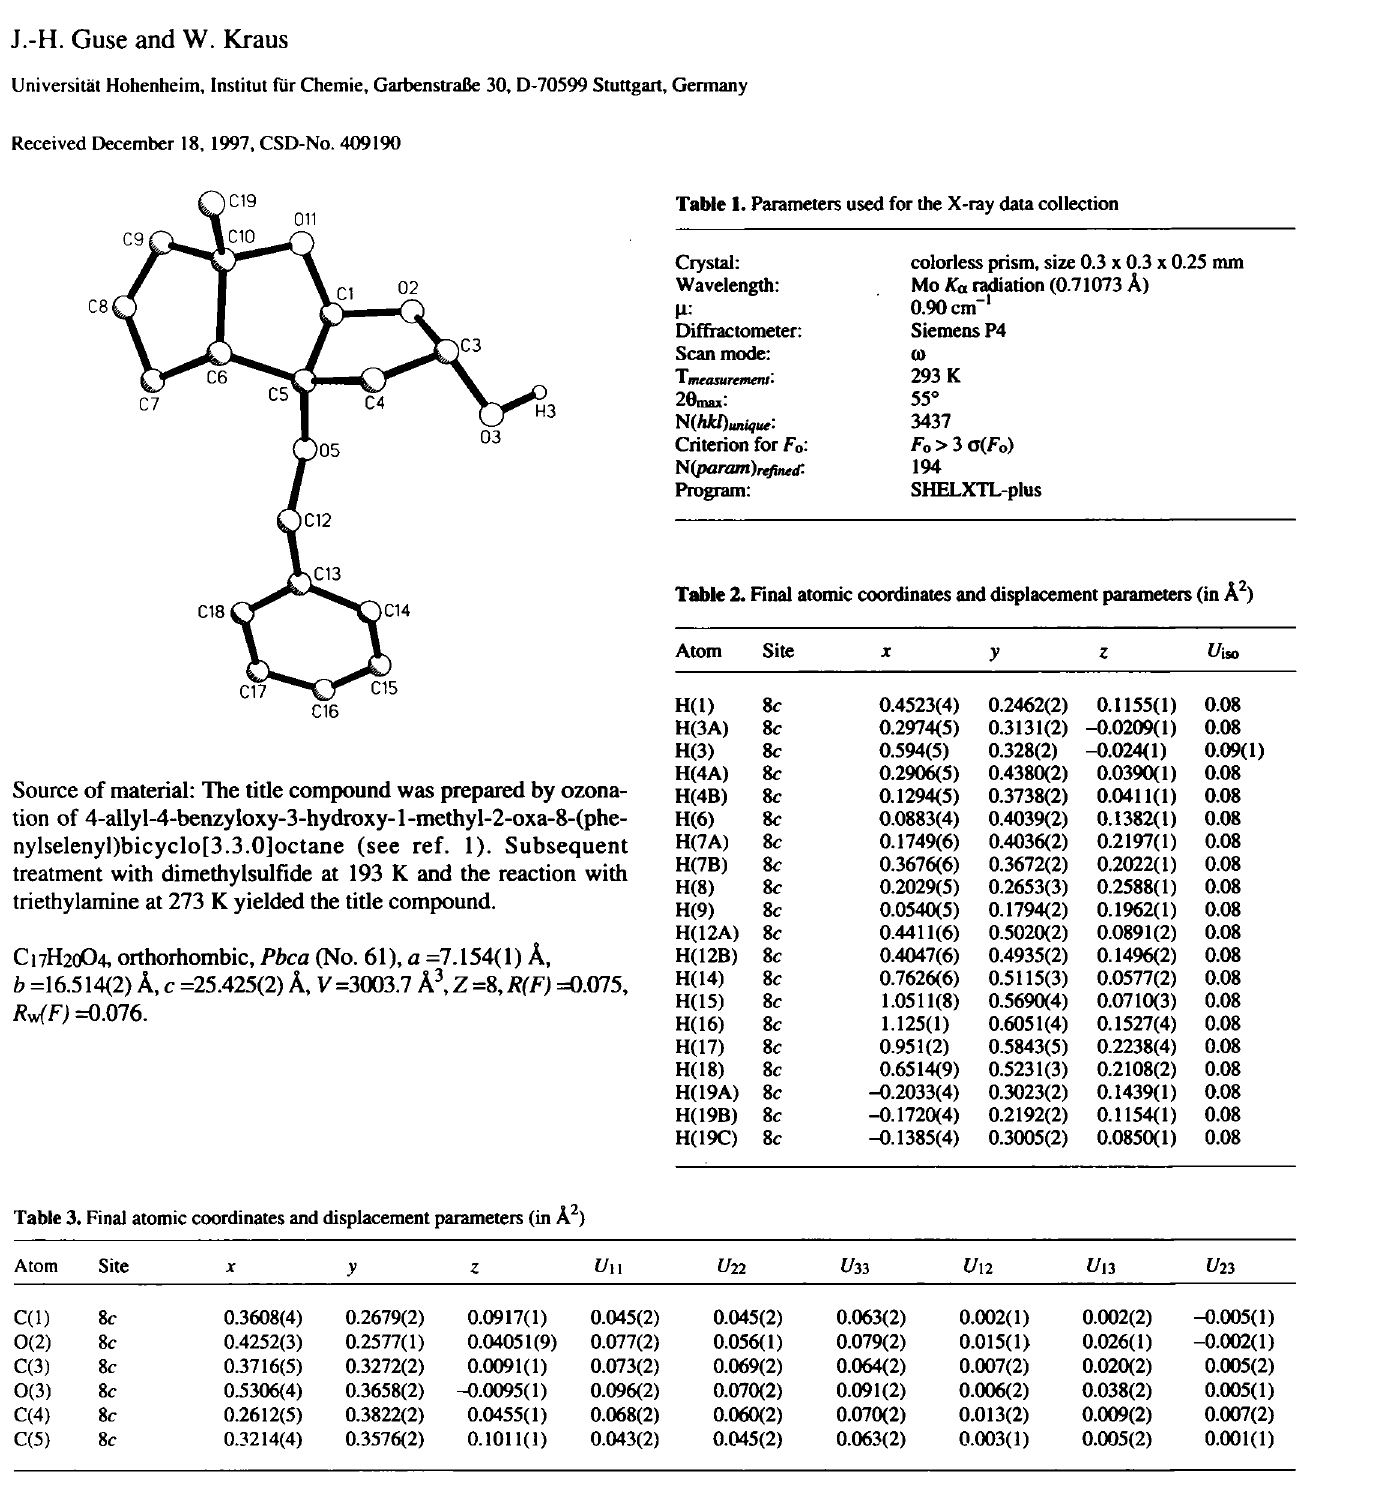
Table 3. Final atomic coordinates and displacement parameters (in